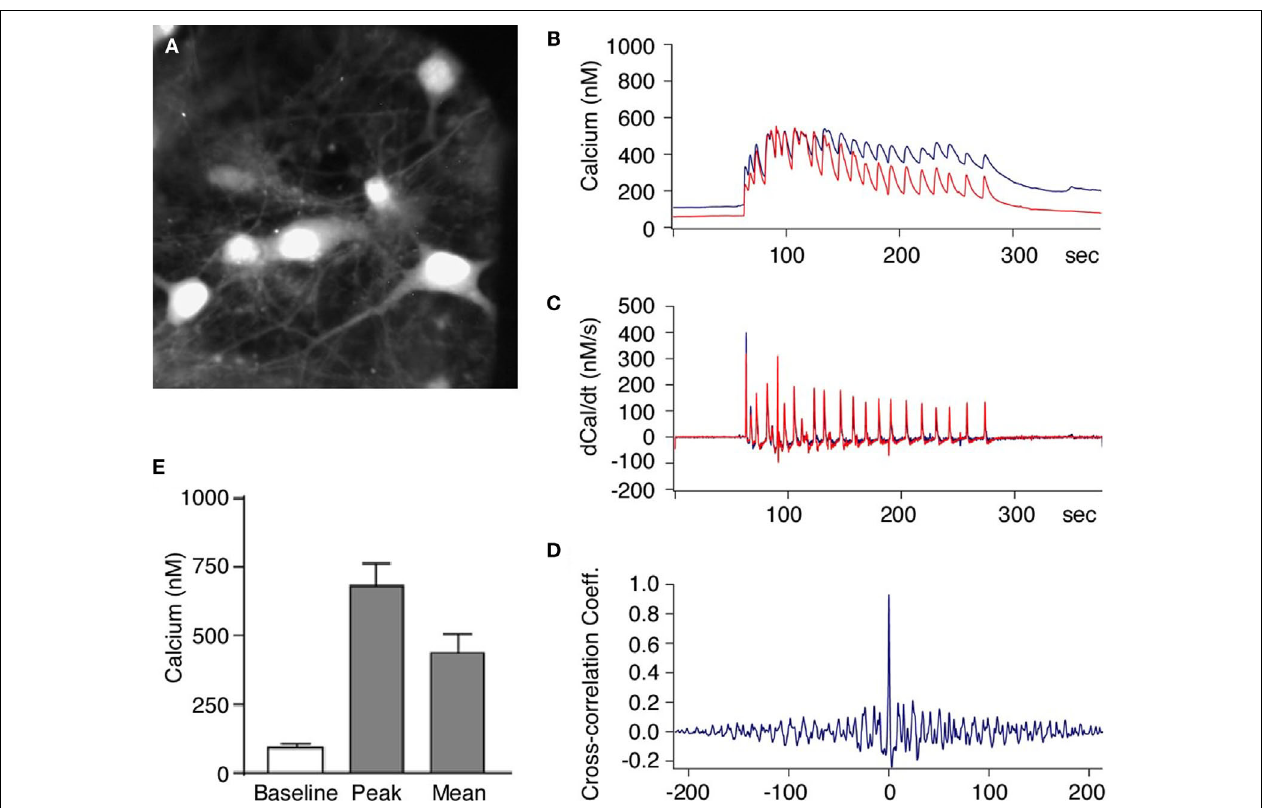
FIGURE 2 | Activation of NMDA receptors induces synchronized increase of intracellular calcium in neurons within hippocampal neuronal network. (A) Primary hippocampal neurons loaded with the Ca 2 + indicator dye Fura-2. The neurons were then stimulated with Mg 2 + -free solution and the intracellular Ca 2 + concentration was measured in pairs of neurons. (B–D) Glycine induced increase in intracellular Ca 2 + was synchronous in all neurons and showed simultaneous rise in fl uorescence in different neurons [blue and